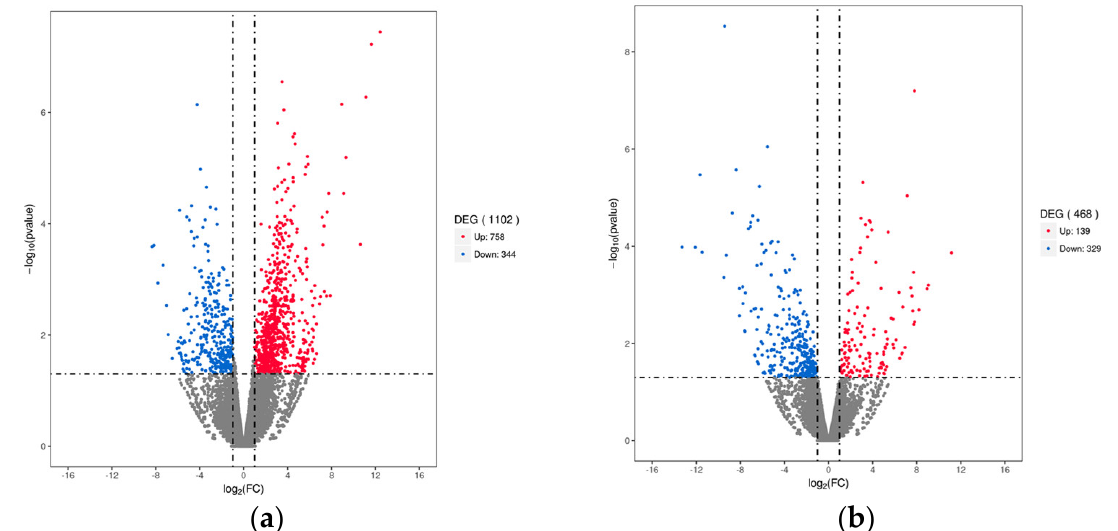
Figure 2. The number of differentially expressed genes between different groups. ( a ) HC_O vs. CG_O group; ( b ) HC_E vs. CG_E group. Significantly up−regulated and down−regulated genes are indicated in red and blue, respectively, and those not significantly different are in gray.